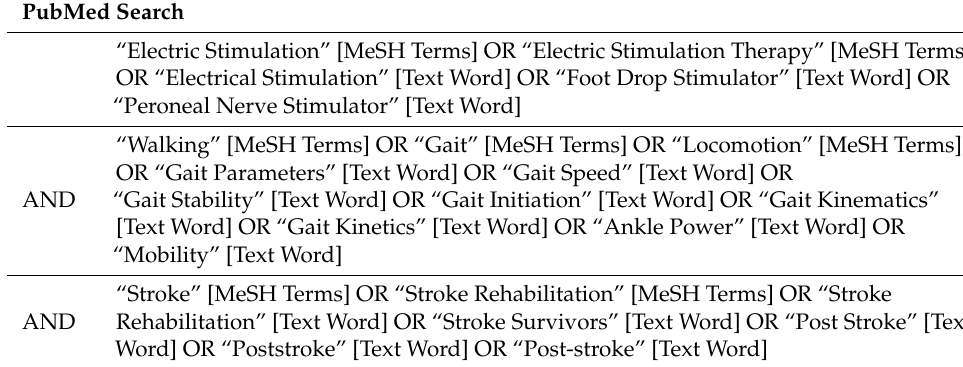
Table 1. Full search